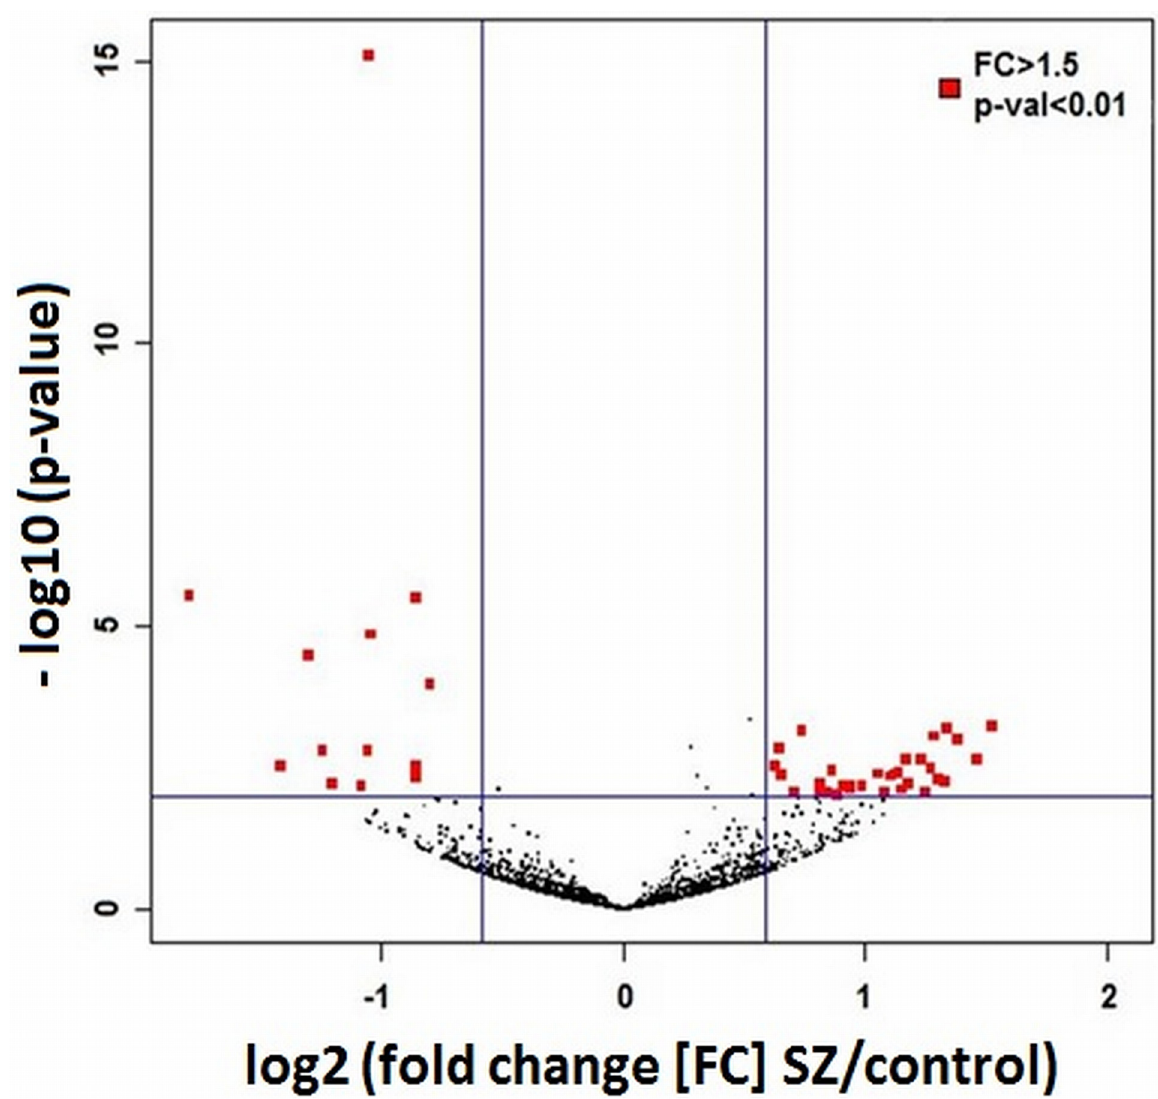
Fig 1. Volcano plot showing statistical significance (-log10 of the p -values) on the y-axis vs fold change of all expressed miRNAs. The 13 miRNAs that were significantly down-regulated in SZ are shown at the left (red squares), while the 32 that were significantly up-regulated in SZ are shown at the right ( p < 0.05 and FC >